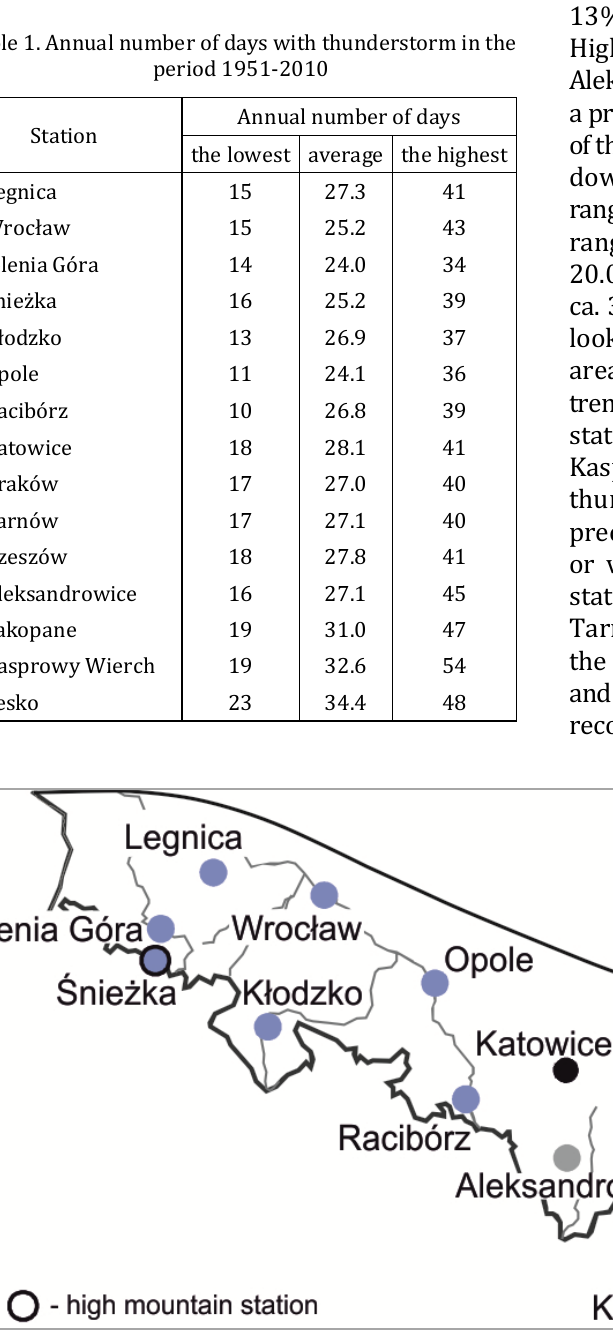
Fig. 2. The groups of stations distinguished by frequency of the occurrence of the thunderstorm days with different precipitation categories in the period 1951-2010 – explanation in the